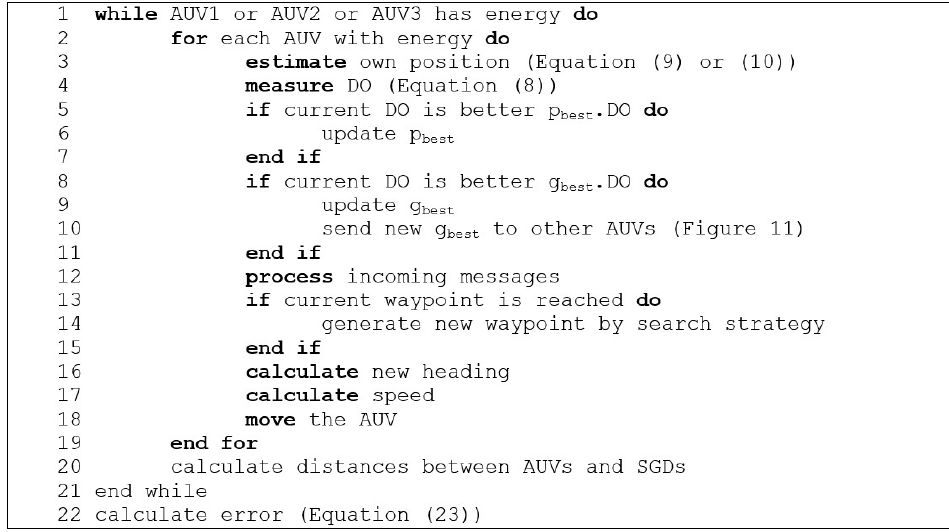
Figure 13. Pseudocode of autonomous underwater vehicle (AUV) search for submarine groundwater discharge (SGD) investigation.